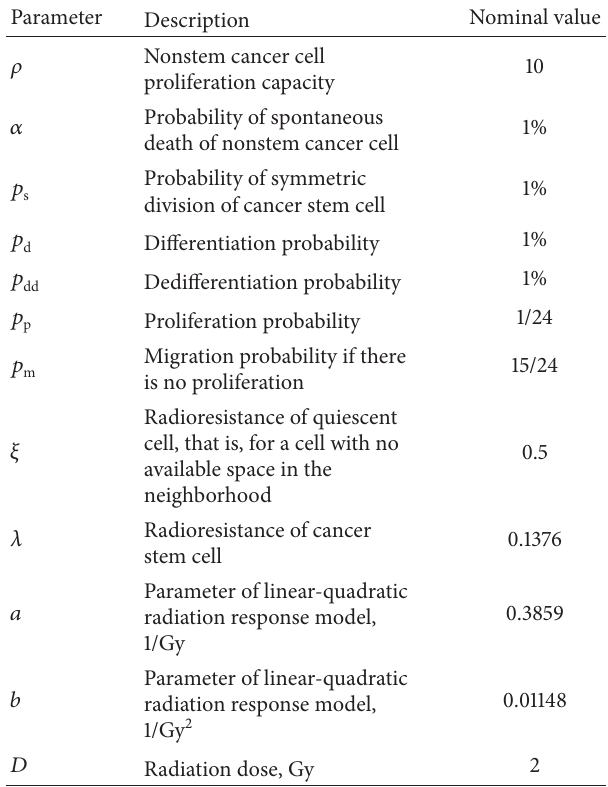
Table 1: Summary of model